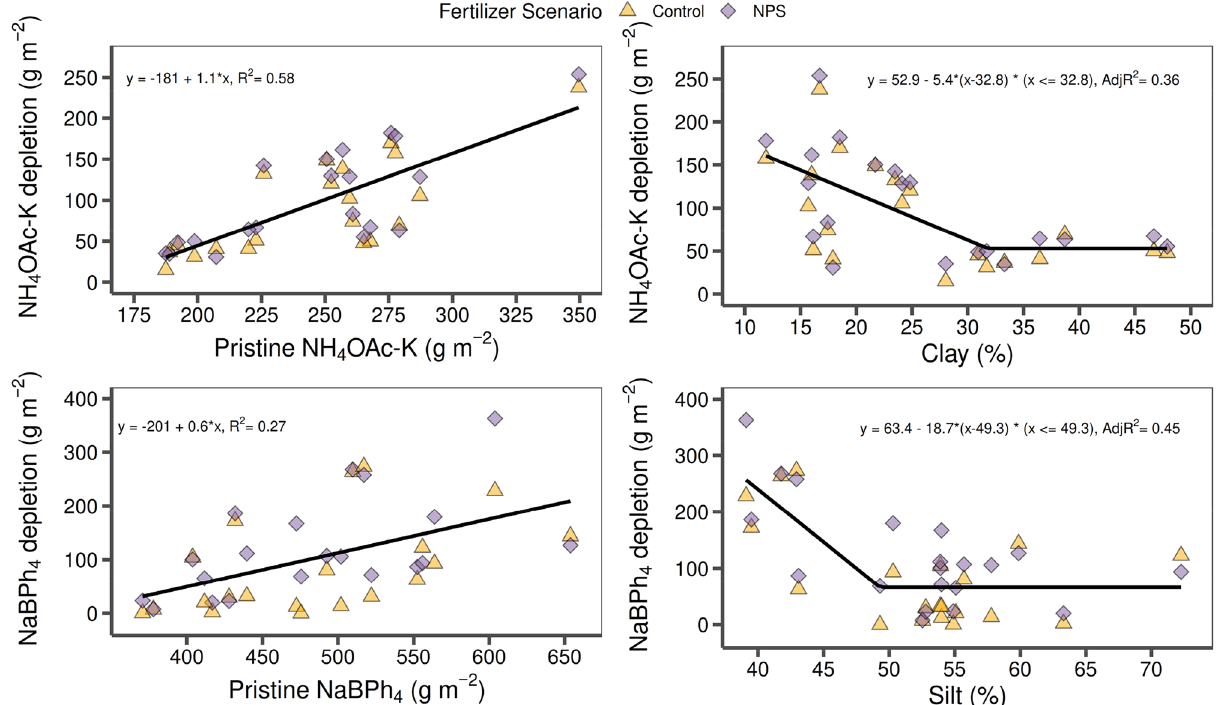
Figure 4. Depletion of NH 4 -OAc-K (upper-panel) and NaBPh4-K (lower-panel) in the agricultural (Control, NPS) with respect to pristine soils as explained by the corresponding pristine-K levels (left) and soil texture related variables, clay and silt content (right). Data points are pooled from the four sites and five soil sampling spring–summer and wheat during the winter-spring seasons. Maize and wheat are usually fertilized with nitro- gen (N), phosphorus (P), and sulfur (S) but at rates below nutrient removal, resulting in negative budgets 43 .